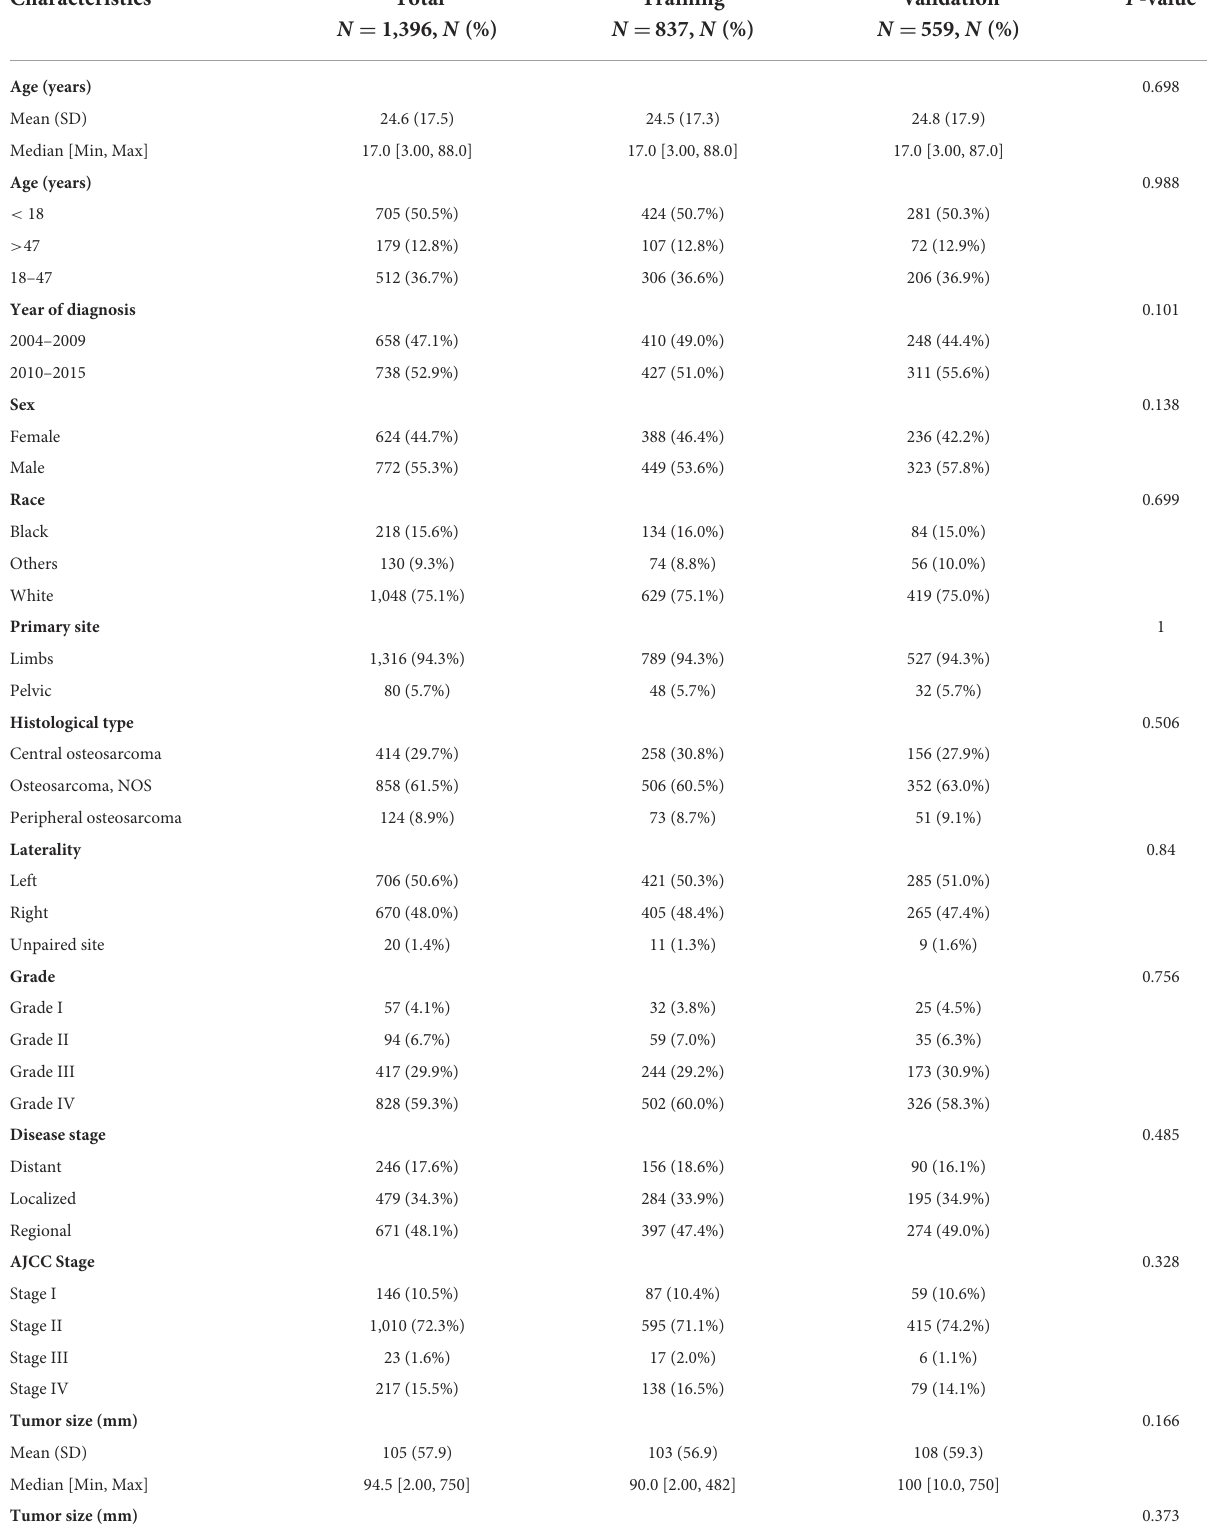
TABLE 1 Baseline demographic and clinicopathological characteristics of the patients.